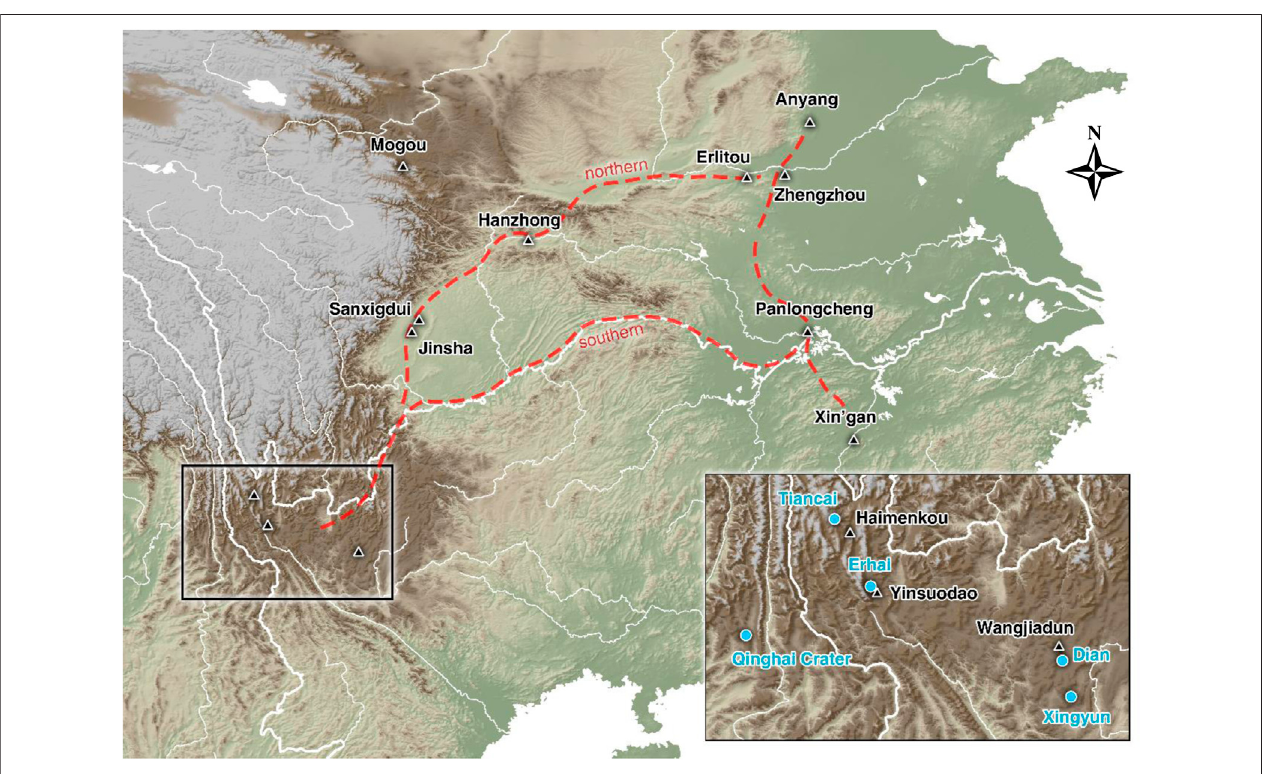
FIGURE 2 | Key archaeological sites mentioned in the text and the proposed northern and southern routes of highly radiogenic lead (HRL) from Yunnan to the Central Plains.